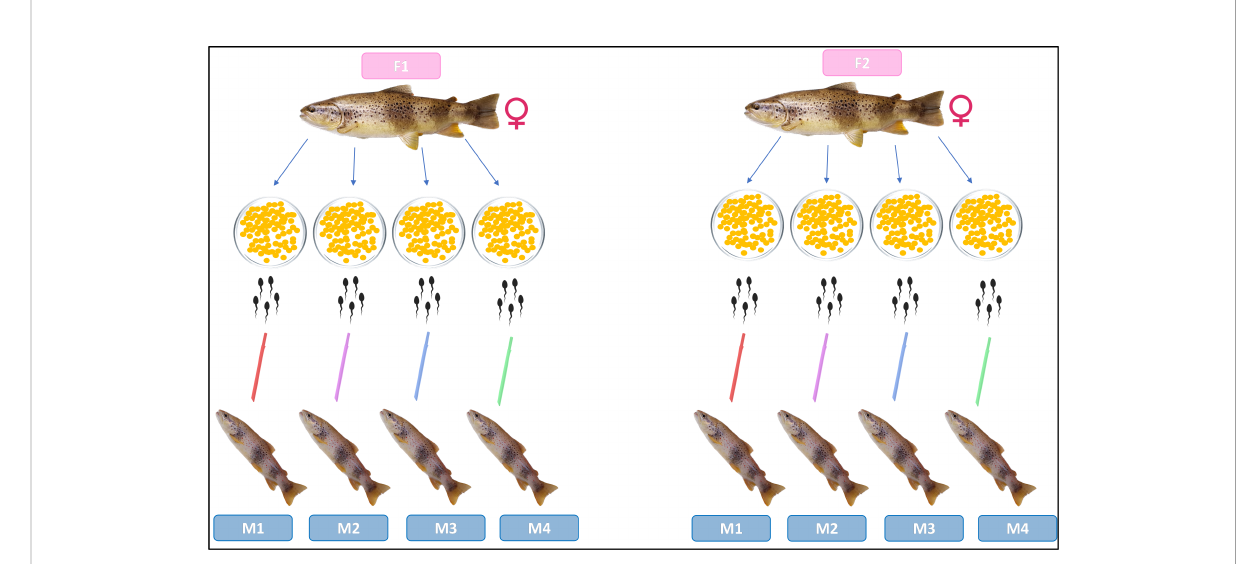
FIGURE 3 Schematic representation of fertilization schemes in arti fi cial fertilization